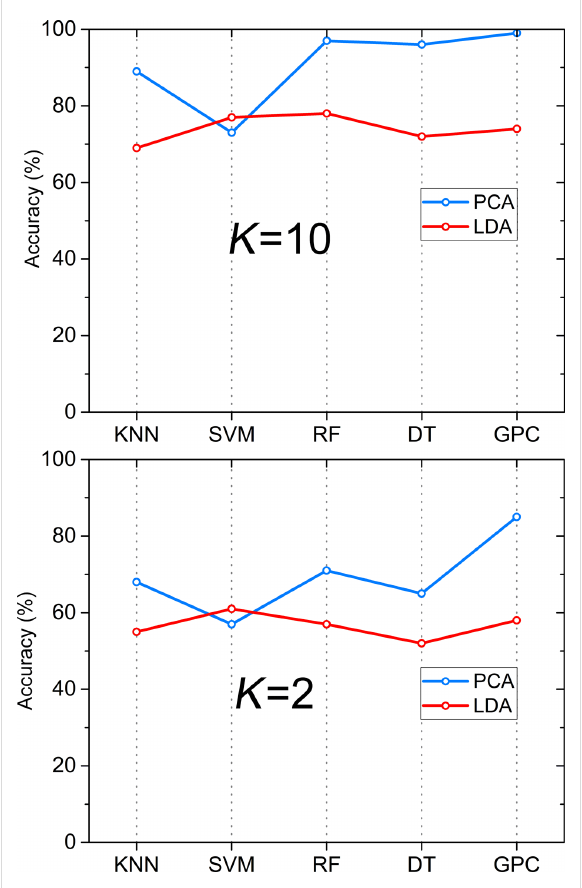
Figure 12: Total classification accuracy using the five classifiers SVM, KNN, DT, RF, and GPC with K -fold cross-validation ( K = 2, K =